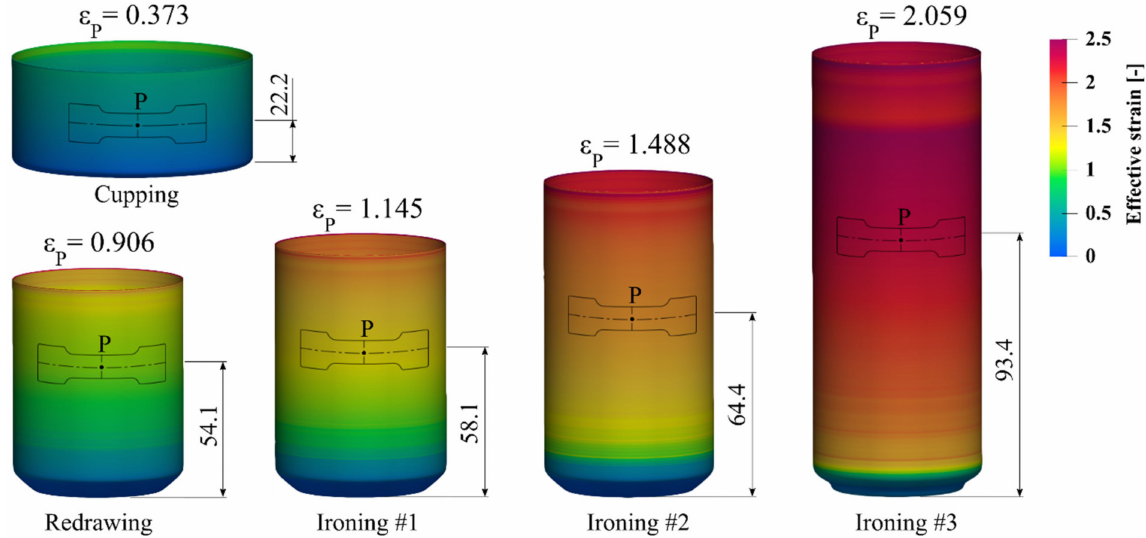
Figure 5. Distribution of the effective strain in the first five steps of the beverage can forming process with an existing model of flow stress.